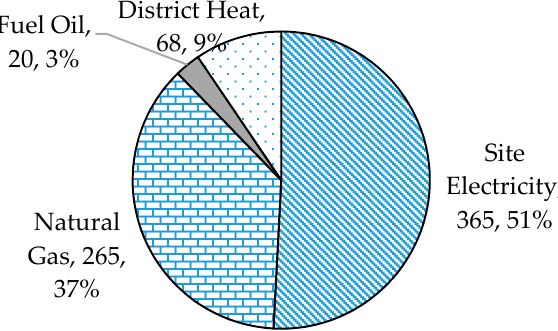
Figure 1. U.S. 2012 energy consumption in the percentage of the total energy consumed in healthcare buildings by energy source .